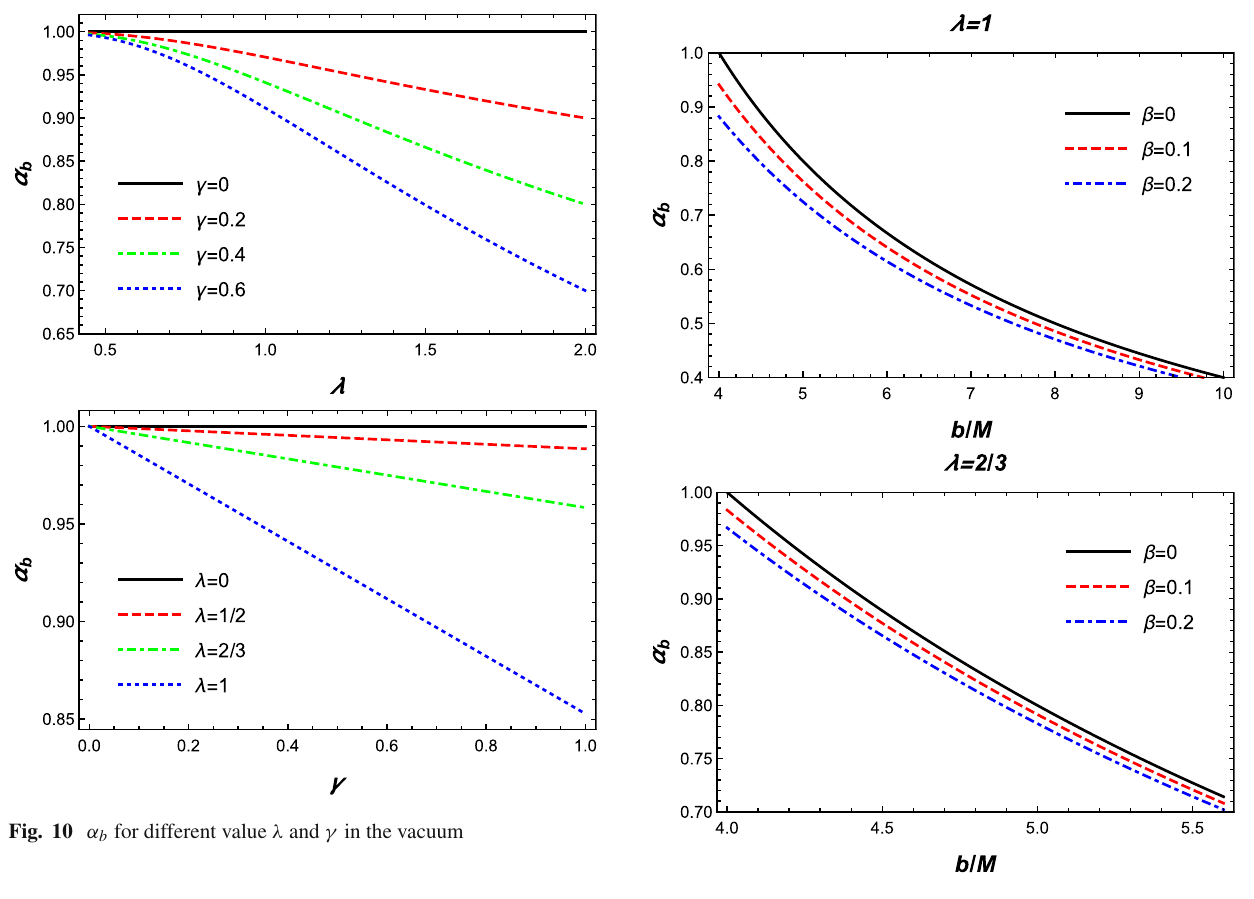
Fig. 11 The dependence of the deflection angle on the impact param- eter b for the different values of parameters β and λ in KR gravity